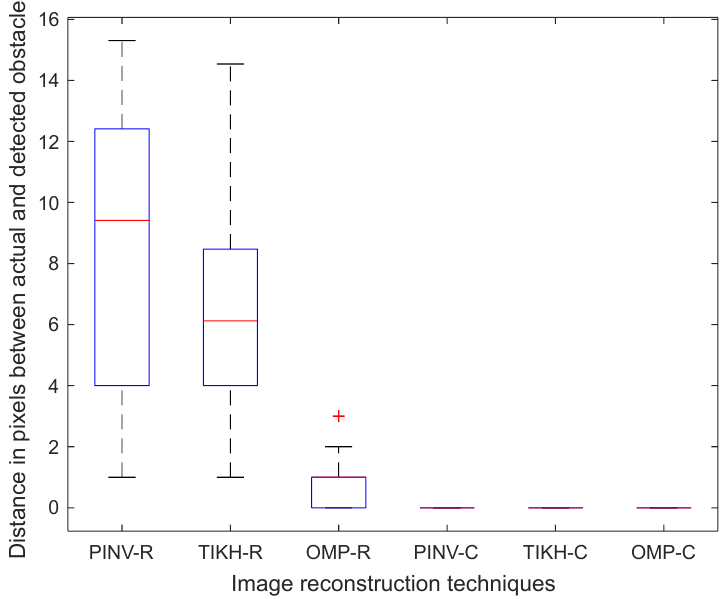
Figure 19. Euclidean distance in pixels between three reconstructed obstacle coordinates and their actual coordinates in the